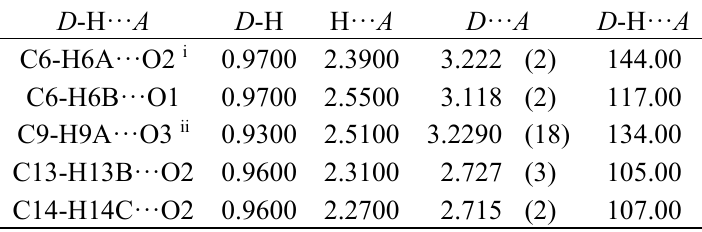
Table 7. Hydrogen-bond geometry (Å, °) of compound 2b .